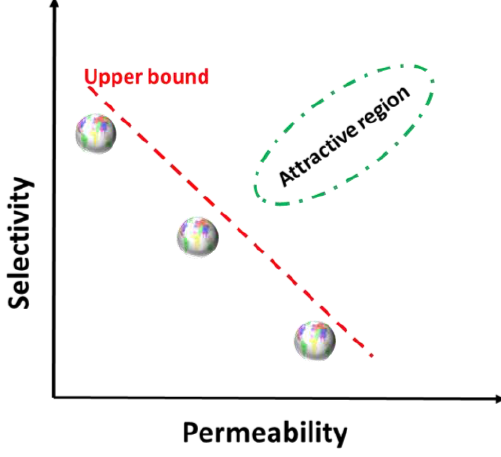
Figure 2. Schematic showing the trade-off between permeability and selectivity of synthetic nanofiltration (NF) membranes.